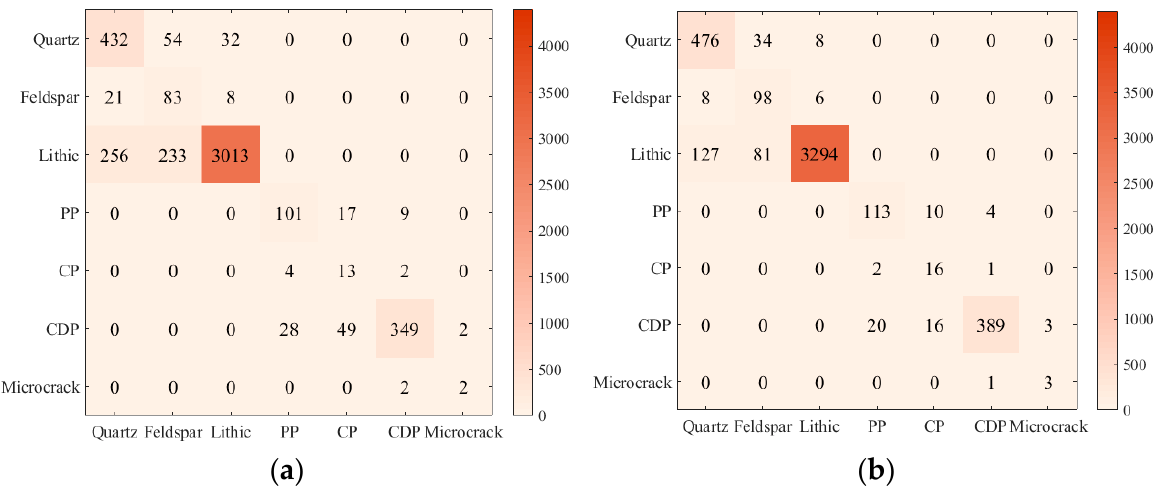
Figure 8. Confusion matrix of the two algorithms: ( a ) SYL confusion matrix, ( b ) SMR confusion matrix.